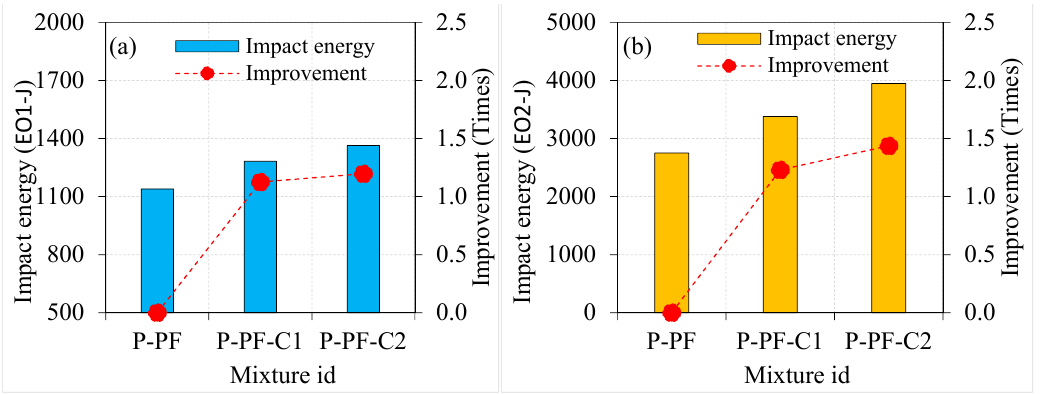
Figure 11. Effect of asphalt coating on impact strength of PF-based specimens ( a ) EO1 and ( b ) EO2.